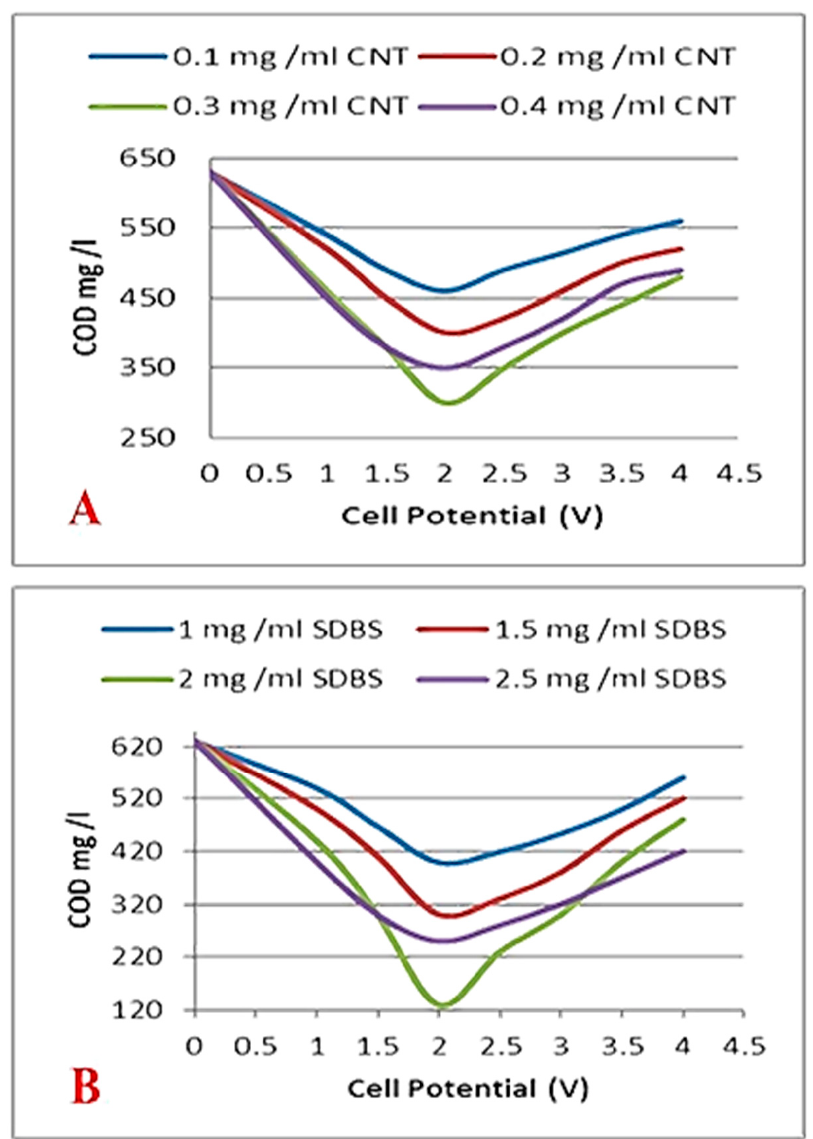
Figure 7. Electro-oxidation COD as a function of ( A ) carbon nanotube (CNT) loading, ( B ) surfactant concentration, and total cell potential.